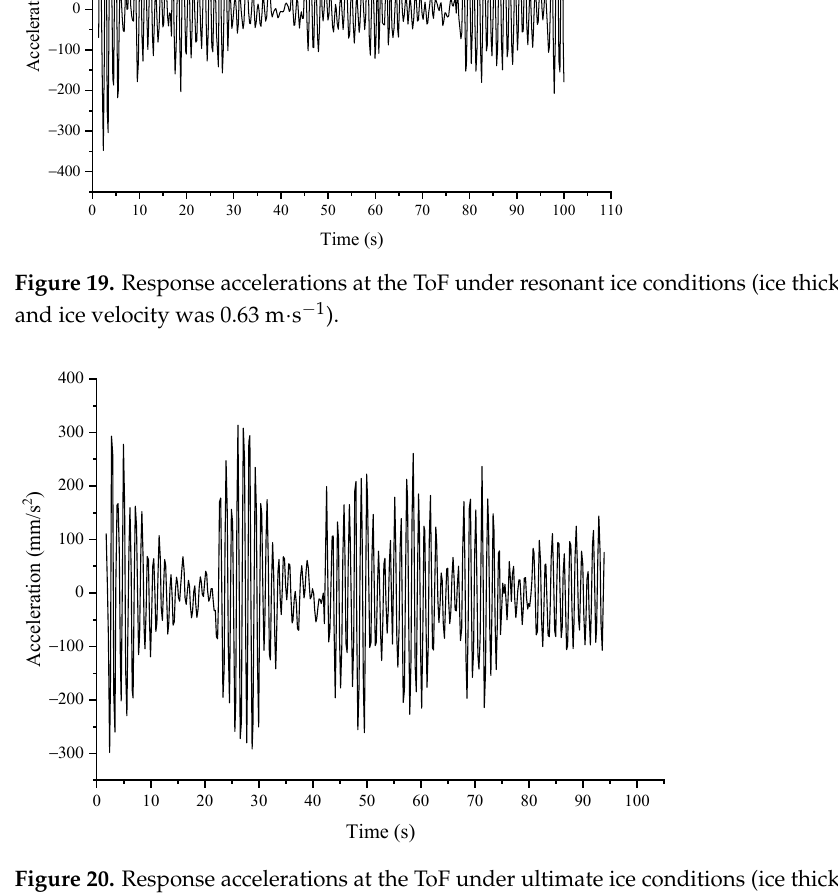
Figure 20. Response accelerations at the ToF under ultimate ice conditions (ice thickness was 0.32 m